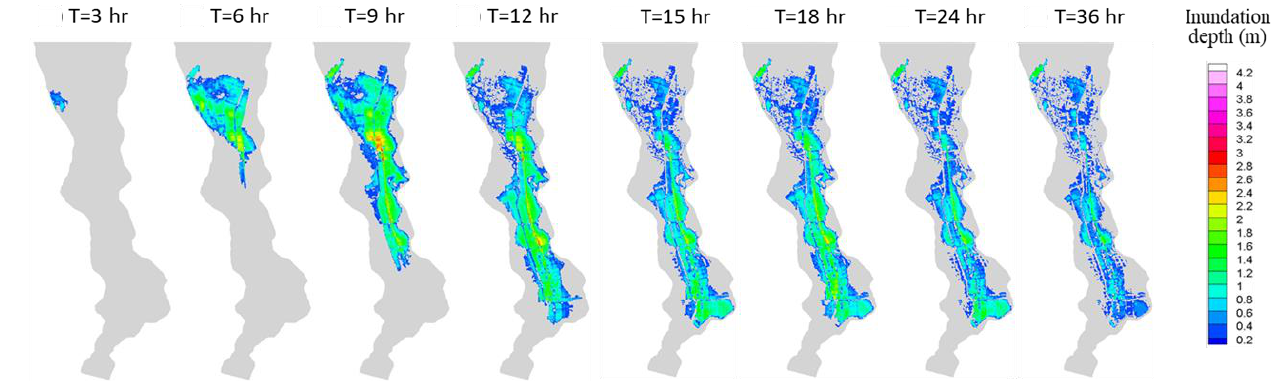
Figure 17. Water depth variation in RWRB (Case 3).